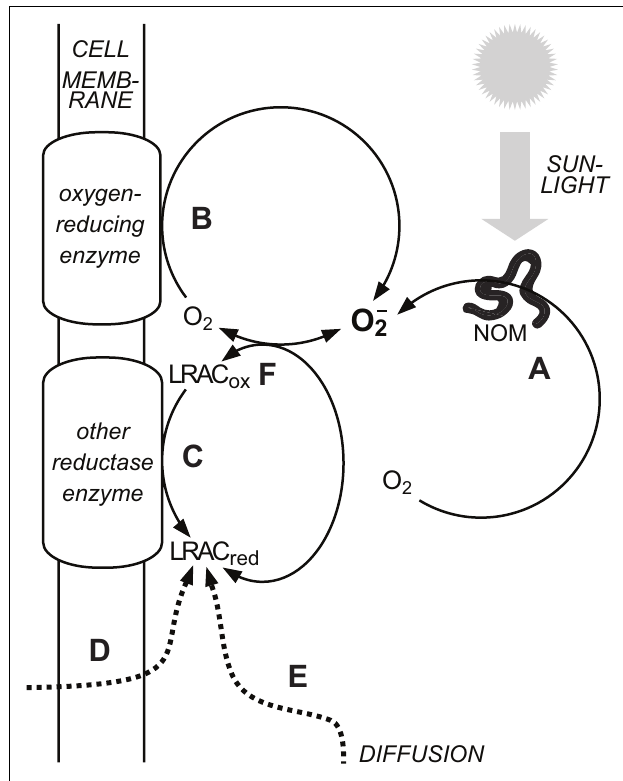
FIGURE 1 | Major sources of O −∗ in natural waters. (A) Abiotic, 2 photochemical oxidation of natural organic matter (NOM) with concomitant reduction of O 2 . (B) Biological reduction of O 2 in the extracellular milieu via cell surface enzymes. (C) Biological reduction of oxidized labile redox-active compounds (LRAC ox ) in the extracellular milieu to form reduced labile redox-active compounds (LRAC red ) that subsequently reduce O 2 to O −∗ . (D) 2 Biological release of LRAC red into the extracellular milieu that subsequently reduce O 2 to O −∗ . (E) Diffusion of LRAC red produced under suboxic 2 conditions into more oxygenated waters. (F) The O 2 / O −∗ couple readily 2 exchanges electrons with a range of other labile redox-active compounds in the extracellular milieu. Decay pathways for O −∗ are not 2